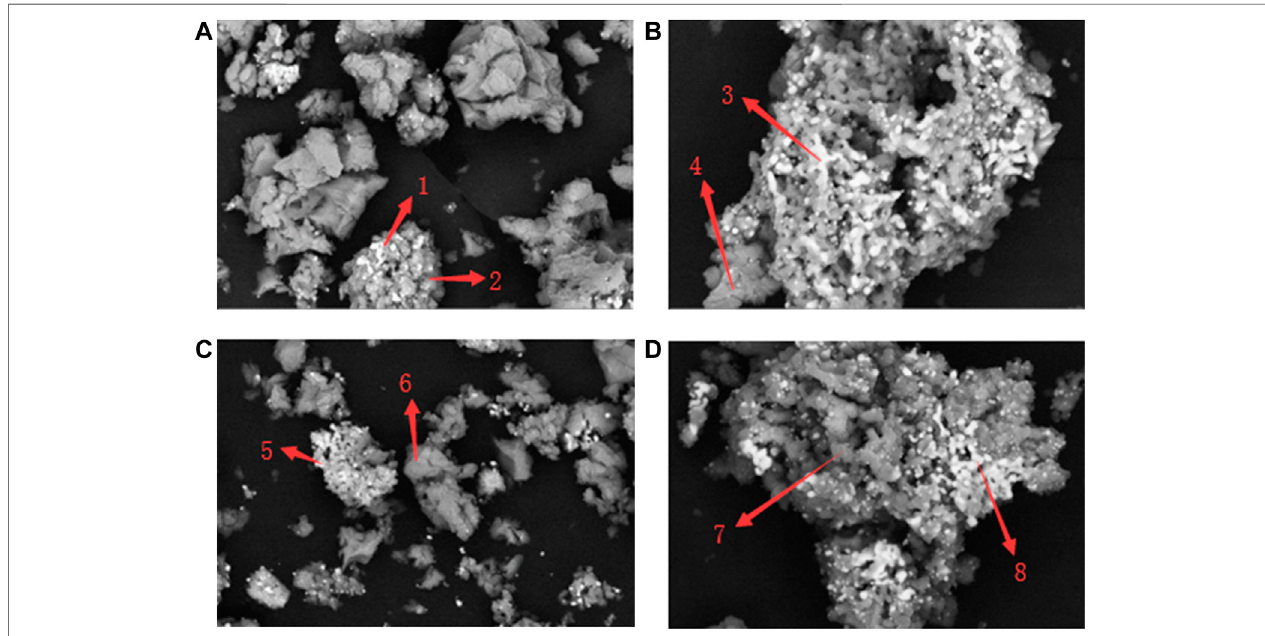
FIGURE 10 | SEM spectra of Fe-modi fi ed catalysts with different doping mass proportions: (A) 3%, (B) 6%, (C) 9%, and (D) 12%.